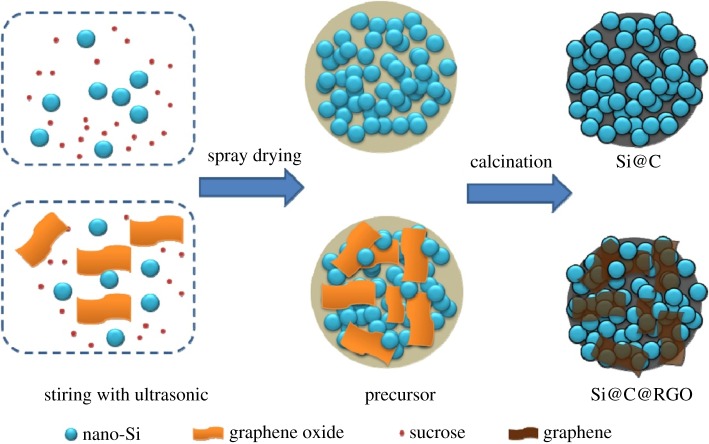
Schematic illustration of the synthesis of Si@C@RGO [88].